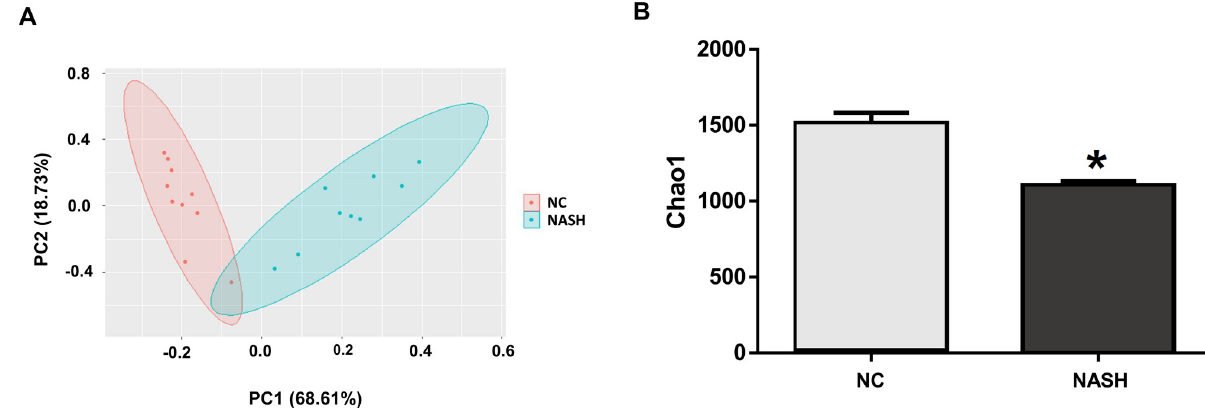
Fig 3. Microbial composition. ( A ) PCA obtained through cluster analysis of the NC (control group) and NASH group samples. ( B ) Alpha diversity estimated by the Chao1 diversity index for feces samples from the NC and NASH groups ( � p < 0.05).